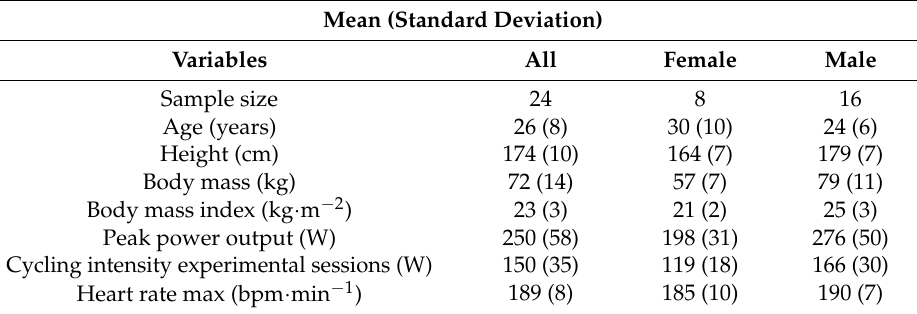
Table 1. Anthropometrical and physiological characteristics of